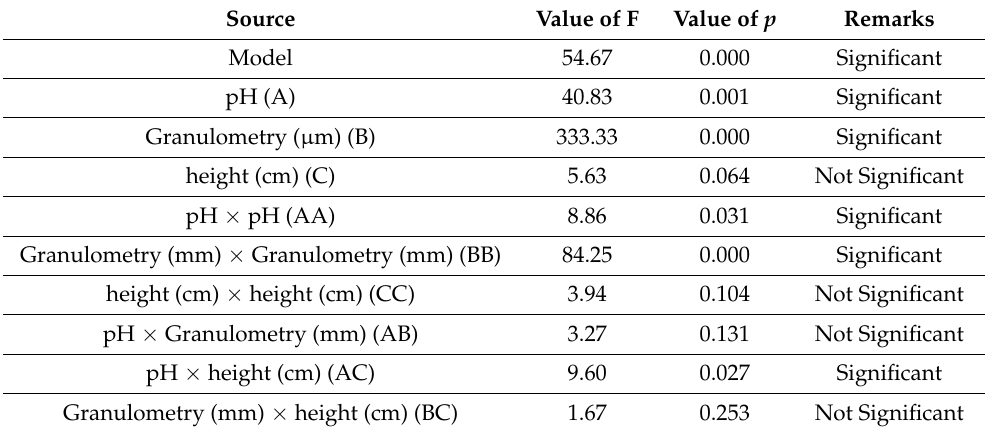
Table 3. Regression of the response surface: EC RP (%) as a function of the grain size ( µ m), height (cm) and